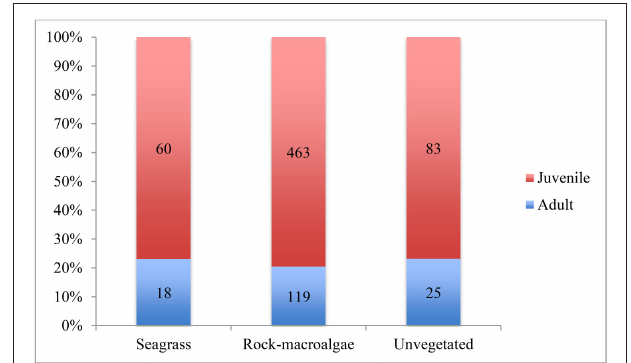
FIGURE 5 | Proportion of juvenile and adult fish for each habitat. Numbers shown in the bars represent number of fish specimens that could be measured for length and therefore analyzed for life stage. The figure includes C. harengus